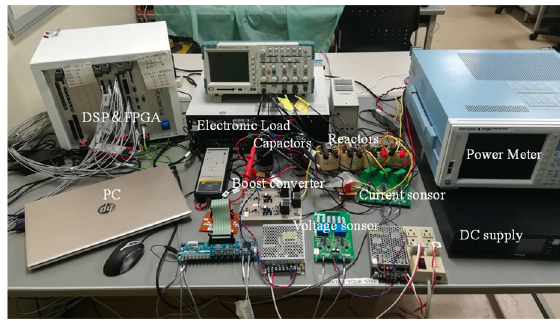
Figure 9. Experimental setup.